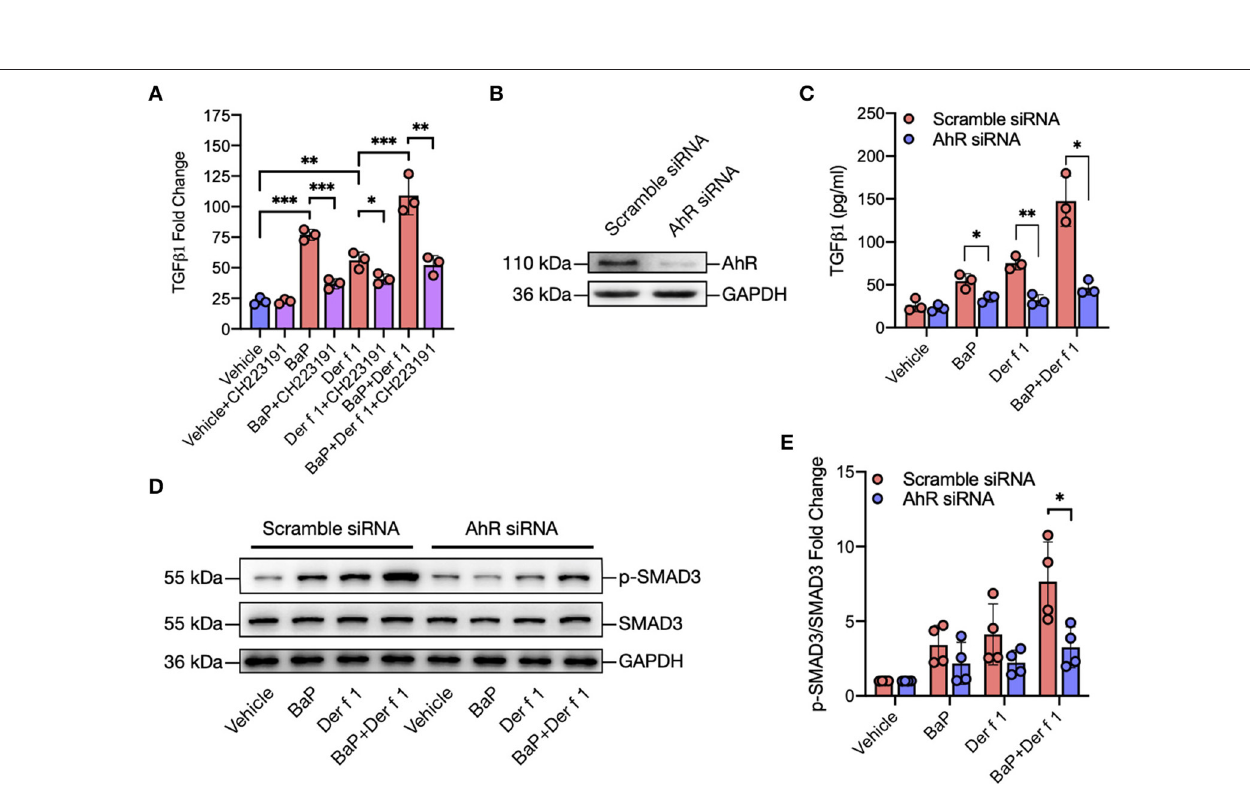
FIGURE 3 | AhR mediates BaP co-exposure-induced TGF β 1 secretion and signaling activation. (A) Levels of TGF β 1 in supernatants of 16HBECs treated with BaP (1 µ M) and Der f 1 (30 µ g/ml) alone or in combination in the presence or absence of CH223191 (10 µ M). (B) Western blot analysis of AhR knockdown in 16HBECs. (C) Levels of TGF β 1 in supernatants of 16HBECs with or without AhR knockdown after exposure to BaP (1 µ M) and Der f 1 (30 µ g/ml) alone or in combination. (D) Western blot analysis of p-Smad3 expression in BaP co-exposure-treated 16HBECs with or without AhR knockdown. (E) Quantitative analysis of Western blots in (D) . Data represent mean ± SEM. * p < 0.05, ** p < 0.01, and *** p < 0.001.